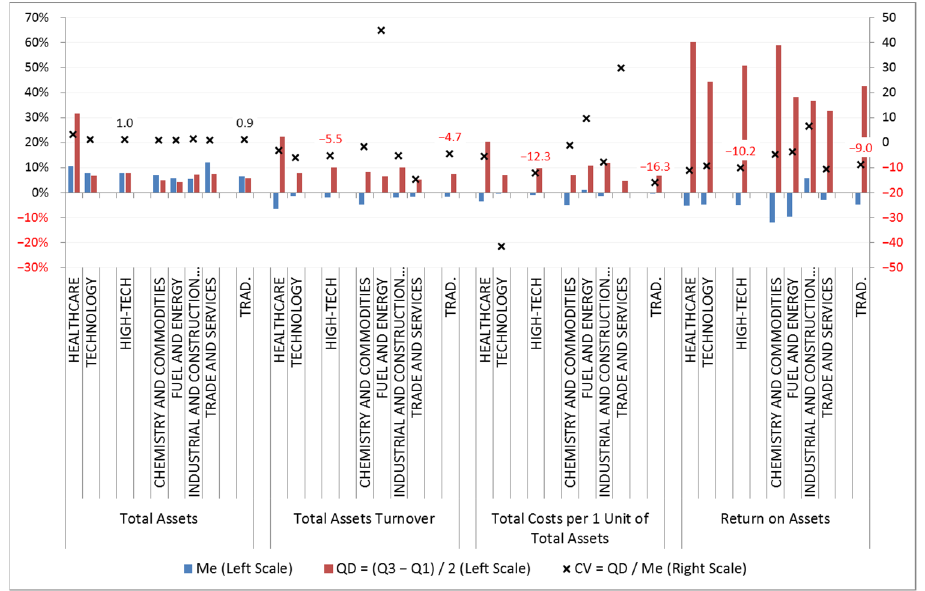
J. Open Innov. Technol. Mark. Complex. 2022 , 8 , 155 Figure 20. Assessment of variation in the area of assets in the analysed sectors. Source: own work.